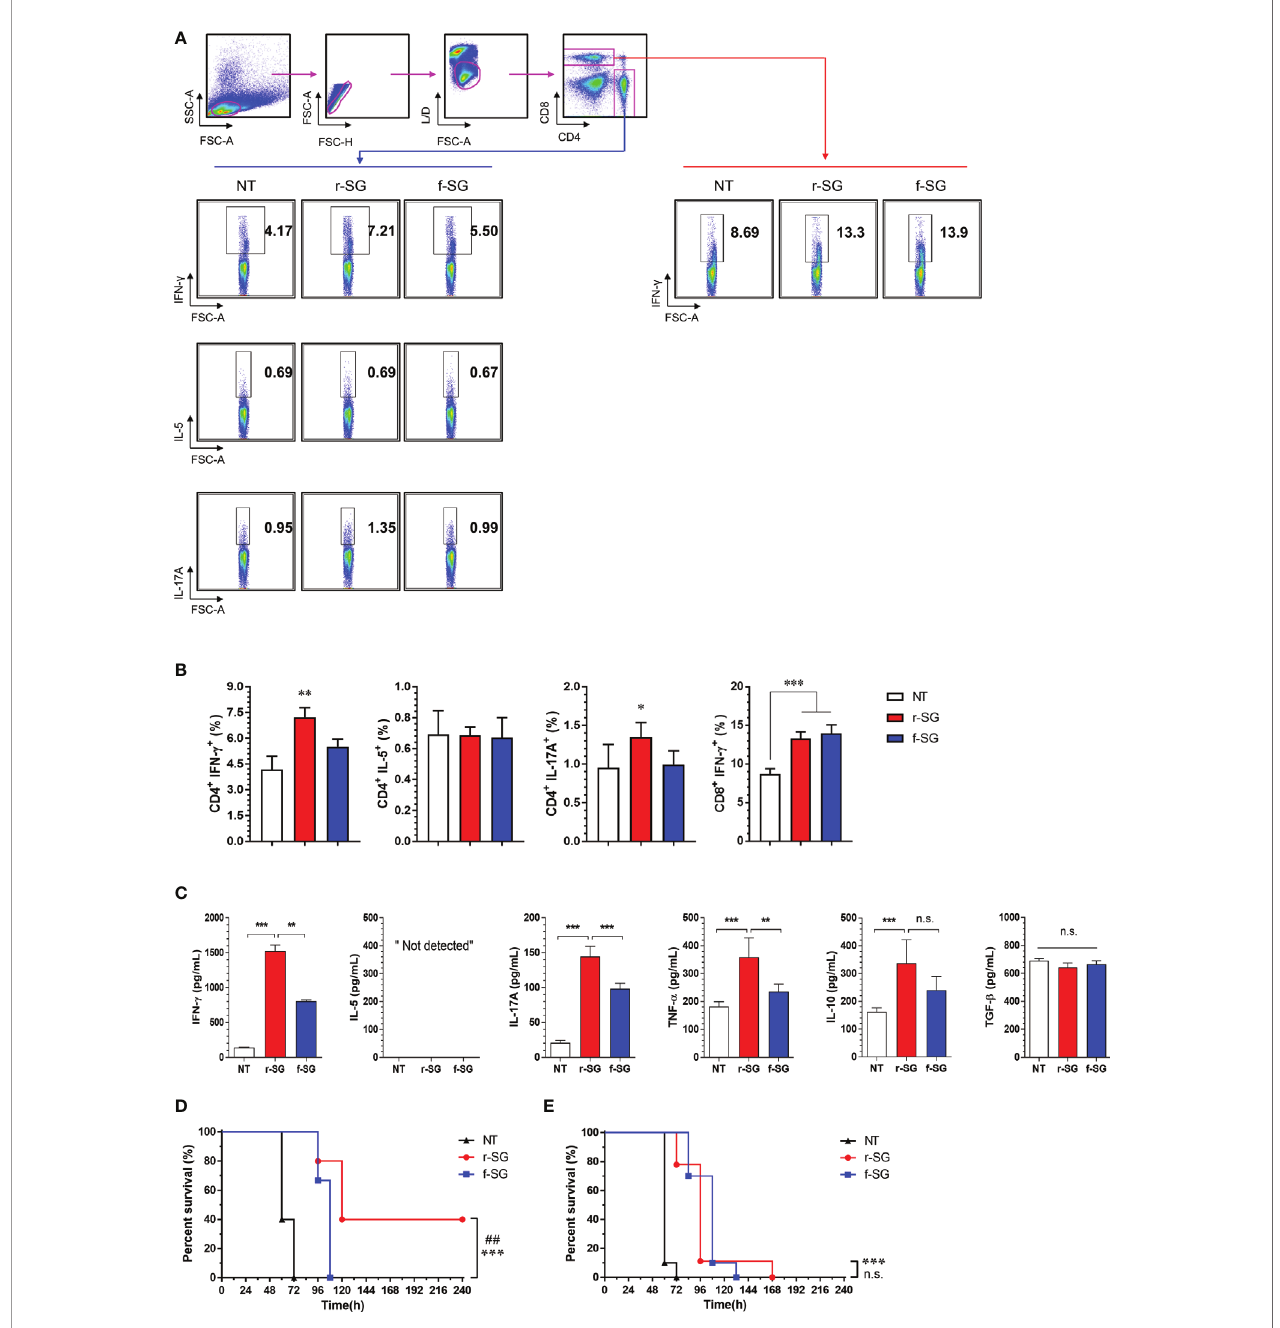
FIGURE 4 | Analysis of SG-speci fi c CD4 + and CD8 + T-cell responses. Mice (n = 5 per group) were immunized i.p. with 1 × 10 6 CFU of r-SG or f-SG three times at two week intervals. Spleen cell suspensions were re-stimulated with 10 m g/mL SG lysate for 12 h and SG-speci fi c Th1 (IFN- g -expressing CD4 + T cells), Th2 (IL-5- expressing CD4 + T cells), Th17 (IL-17A-expressing CD4 + T cells), and activated CD8 + T cells (IFN- g -producing CD8 + T cells) were analyzed by intracellular cytokine staining based on the T cell-speci fi c makers (anti-CD4, and anti-CD8). (A) Representative plots for Th1, Th2, Th17, and activated CD8 + T cells in spleens from PBS-, r-SG-, and f-SG-vaccinated mice. (B) Percentages of Th1, Th2, Th17, and activated CD8 + T cells in spleens of all vaccinated mice. The mean ± SD shown are representative of three independent experiments. (C) Single cell suspensions of splenocytes were treated with 10 m g/mL SG lysate for 72 h, and supernatants were collected for determination of SG-speci fi c cytokines (IFN- g , IL-5, IL-17A, TNF- a , IL-10, and TGF-b) using ELISA. The mean ± SD shown are representative of two independent experiments. *P < 0.05, **P < 0.01, and ***P < 0.001, n.s., not signi fi cant, compared with unvaccinated mice (D) Splenic CD4 + or (E) CD8+ T cells from naïve (n = 7) or r-SG- or f-SG- vaccinated mice were pooled and transferred i.p. to mice. At 12 h after inoculation, mice were challenged i.p. with 5 × 10 5 CFU SG WT strain. Mouse survival was monitored for 10 d. ***P < 0.001, compared with unvaccinated mice. ## P < 0.01, n.s., not signi fi cant, compared with f-SG vaccinated